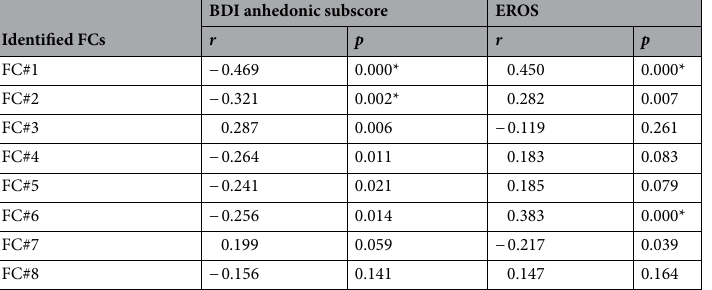
Table 3. Relationship between each functional correlation value and clinical score. Clinical scores associated with anhedonia (BDI anhedonic subscore and EROS). *Bonferroni-adjusted significance level of p < 0.05/8 (= 0.006). BDI Beck’s Depression Inventory, EROS Environmental Reward Observation Scale, FC functional connection.